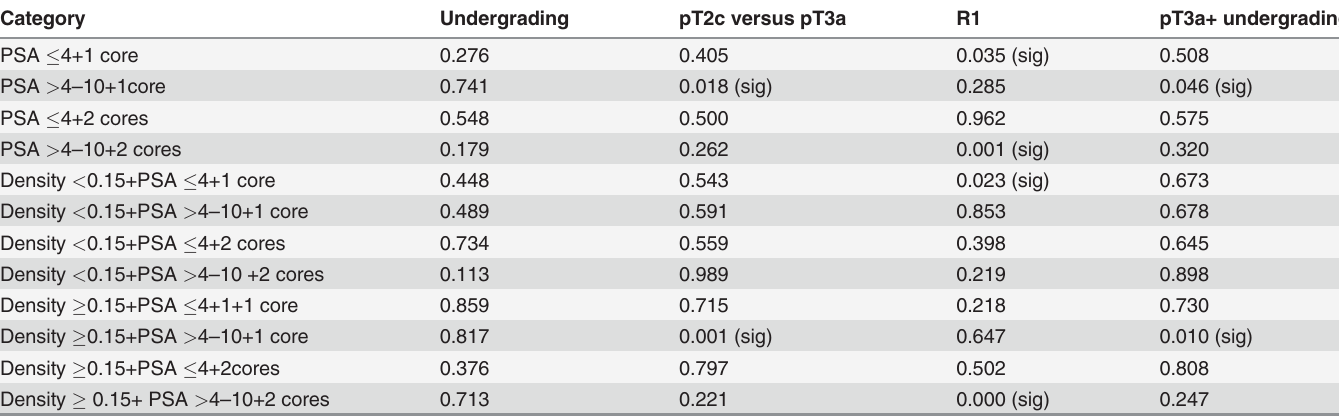
Table 10. Multivariate